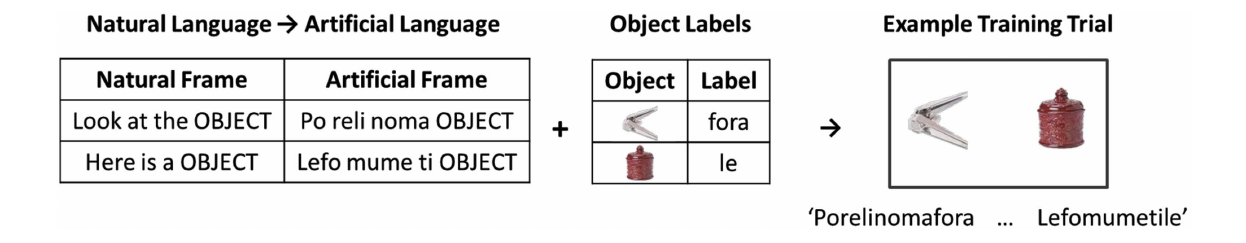
FIGURE 1 |An example training trial from the Full language condition. Trials were constructed by encoding naming event patterns from the child-directed speech corpus into the artificial